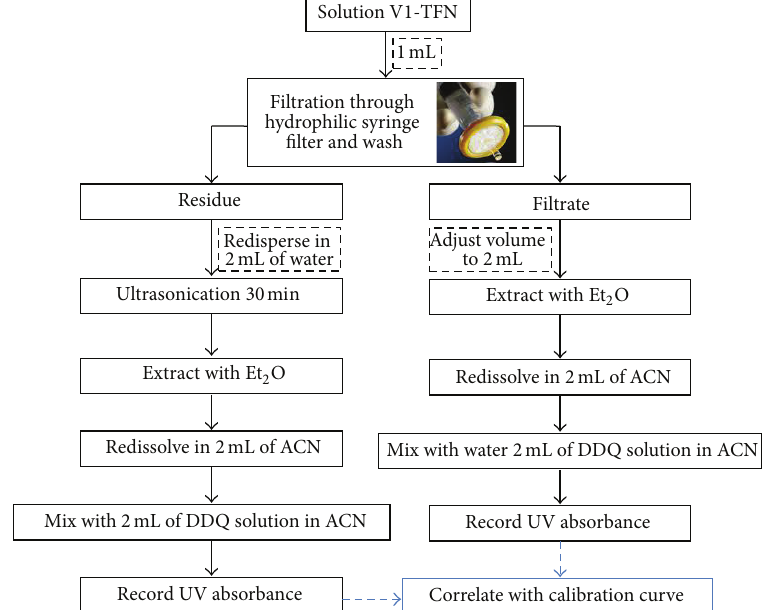
Figure 3: Determination of TFN concentration inside vesicles and in surrounding media (repeated at different time points).